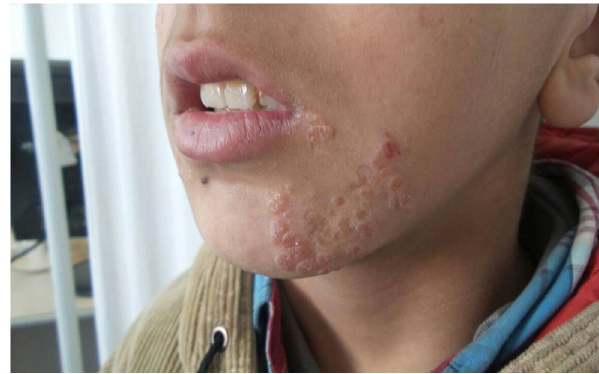
treatment.Figure 1. Multiple yellowish-brown coalescing papular lesions located in the patient’s left cheek.